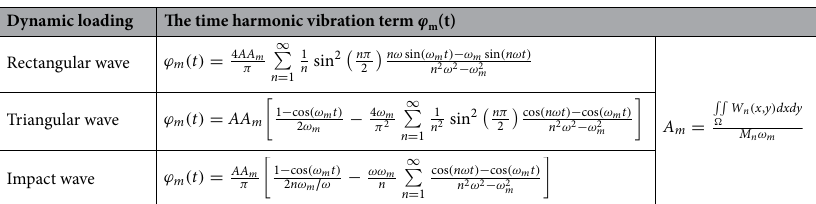
Table 4. The time harmonic vibration term φ m (t) of single-layered thin plate rock mass under dynamic loading.